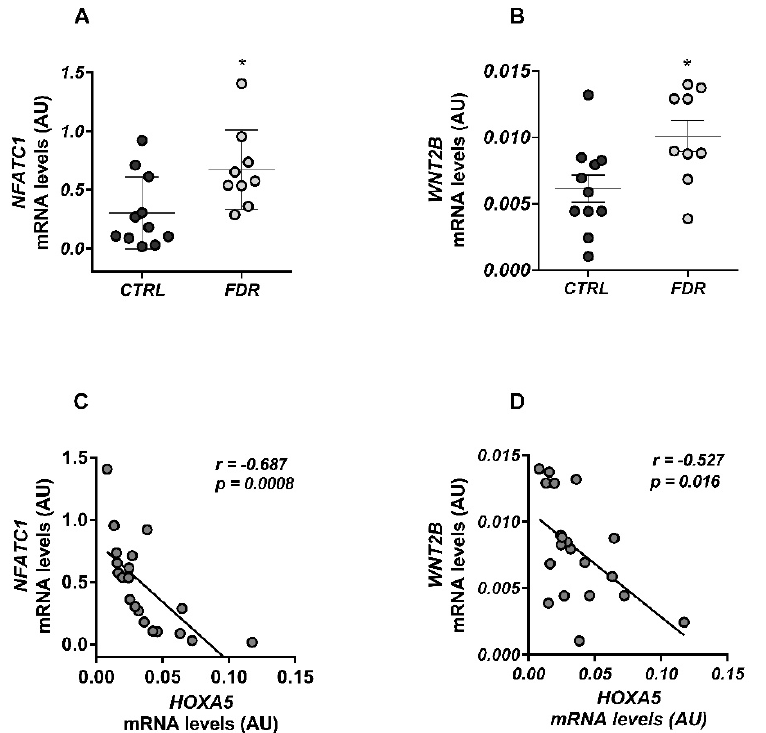
Figure 4. NFATC1 and WNT2B expression and their correlation with HOXA5 mRNA levels in preadipocytes from FDR and CTRL subjects. ( A , B ) The NFATC1 and WNT2B mRNA expression was measured by qPCR in preadipocytes from FDR (n = 9) and control (CTRL; n = 11) subjects available from the study group. Data points represent arbitrary units (AU) from each individual subject. Mean values ± SD are also shown. * p < 0.05 in a two-tailed Mann–Whitney U-test. ( C , D ) Correlation between the preadipocyte NFATC1 and WNT2B mRNA and HOXA5 gene expression in FDR (n = 9) and CTRL (n = 11) subjects available from the study group. The r correlation coefficient and p -value are indicated in the graph.